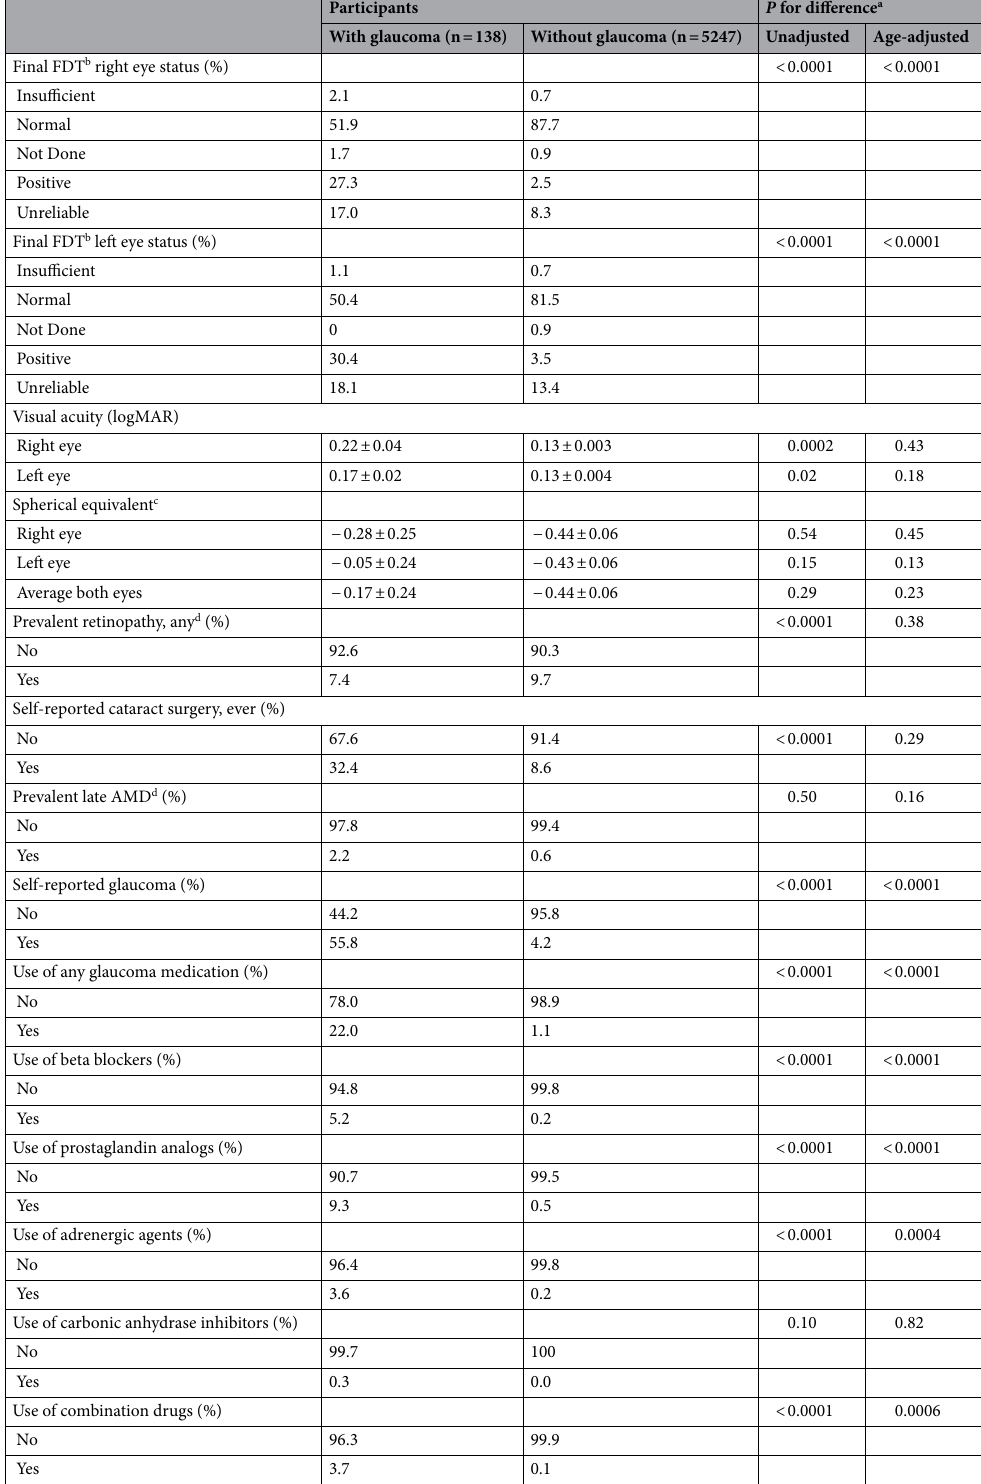
Table 2. Vision and self-reported use of ophthalmic medication of the NHANES 2005–2008 study participants with and without diagnosed glaucoma. All proportions and means (± standard errors) are weighted estimates of the US population characteristics, taking into account the complex sampling design of the National Health and Nutrition Examination Survey. a P values for differences from survey-weighted logistic regression models. b FDT: Frequency Doubling Technology. c Calculated as sphere value plus half the cylindrical power value (347 missing values overall, out of which 14 among glaucoma patients). d Prevalent retinopathy and AMD (age-related macular degeneration) derived from retinal imaging 36